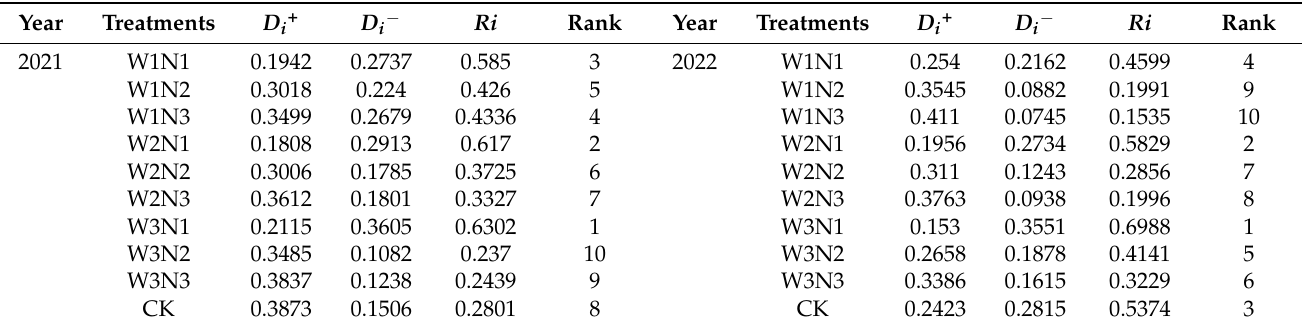
Table 6. Statistics of TOPSIS judging